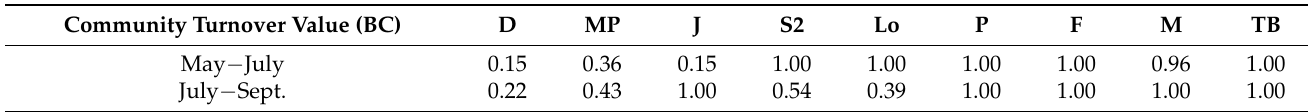
Table 3. The community turnover values for the dominant phytoplankton functional groups in Nanhai Lake.